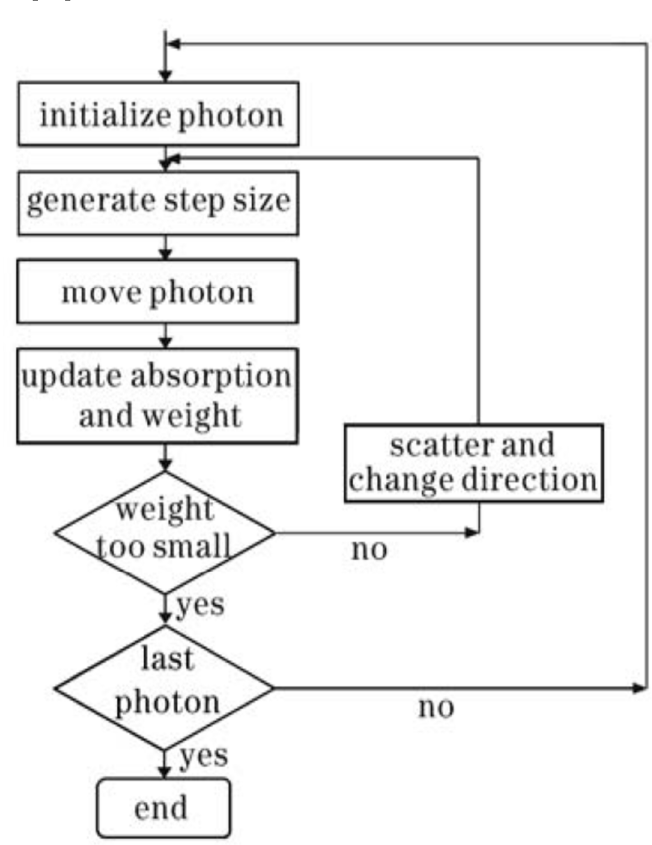
Figure 3. Fundamental steps of MCML technique (adapted from Ref. [53]).